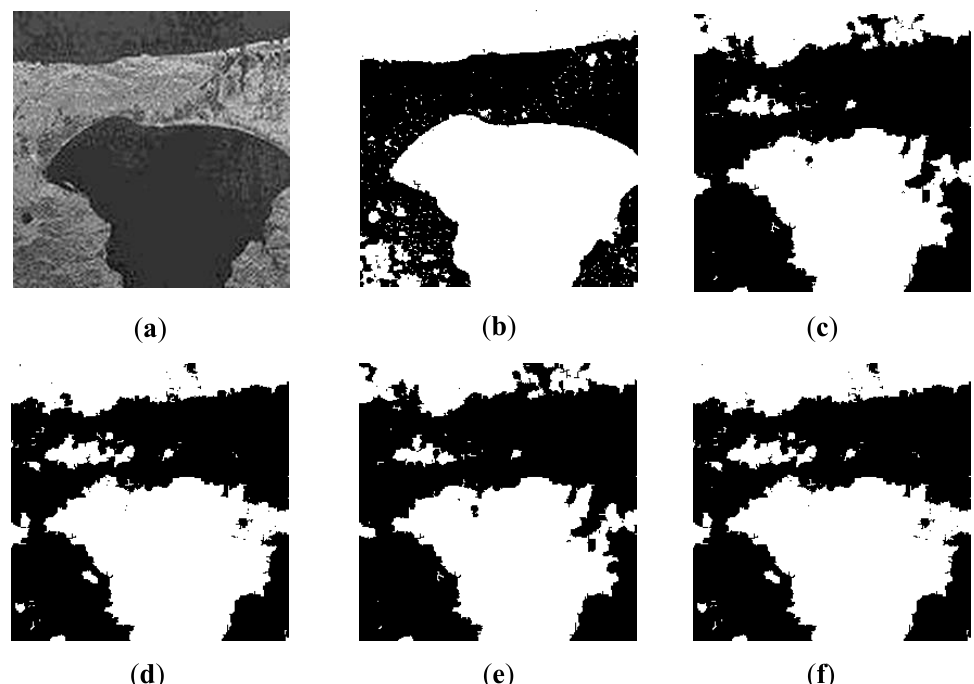
Figure 12. Segmentation results on SAR3. ( a ) original image; ( b ) AFWDLMO; ( c ) AFCMOMA;